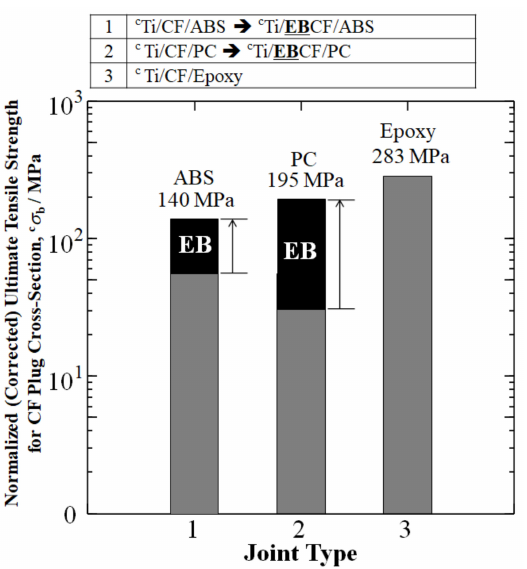
Figure 5. Improvements in corrected (normalized) UTS c σ b for CF plug cross-sections of Ti/TP joints by HLEBI for ABS and PC compared with that of untreated Ti/TS epoxy joint. Data is from: Hasegawa, Faudree, Matsumuara, Jimbo, and Nishi (2016) [10]; Hasegawa, Faudree, Enomoto, Takase, Kimura, Tonegawa, Jimbo, Salvia, and Nishi (2017) [11]; and Nishi, Uchida, Faudree, Kaneko, and Kimura (2019) [46], for titanium joints with ABS, PC, and epoxy, respectively. As mentioned earlier, superscript ‘c’ designates normalized (corrected) UTS according to CF portion of cross-section by rule of mixture